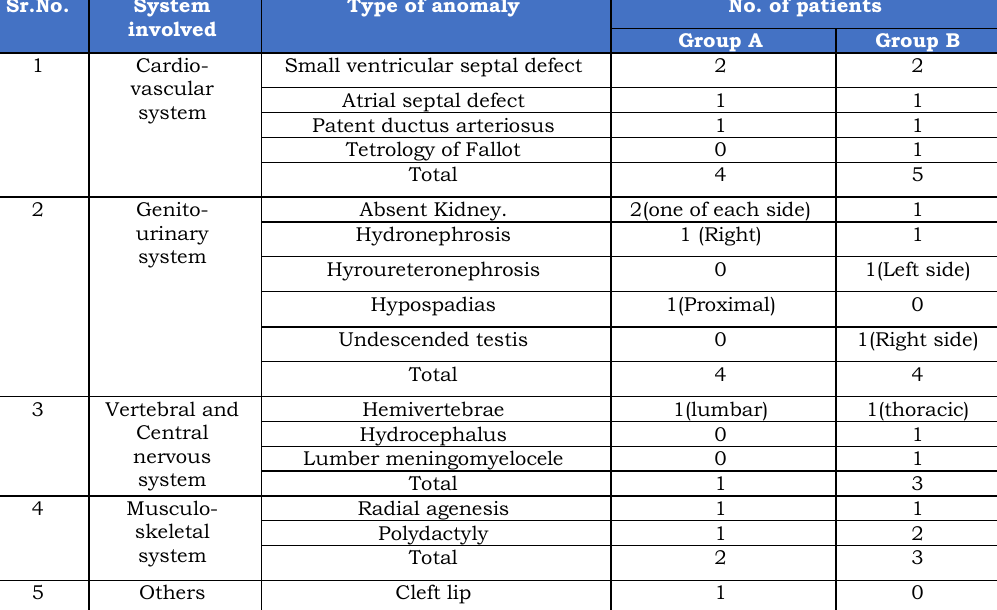
Table 1: Associated Congenital Anomalies